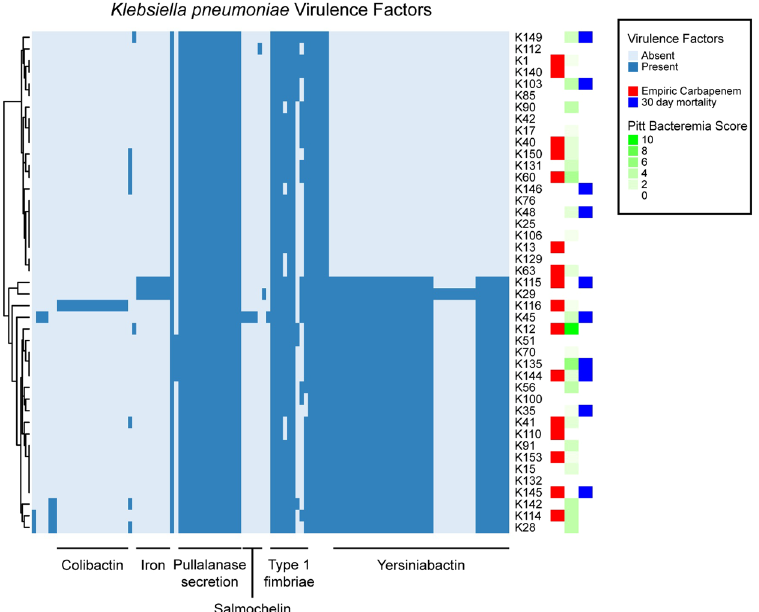
Figure 4. Heatmap of virulence factor calls from based on raw read mapping to VFDB for E. coli strains. Each row represents one E. coli strain, as indicated on the right of the heatmap. The strains are clustered based on their virulence factor profile, with the dendrogram displayed on the left. Each column represents one virulence factor, with selected general classes indicated below; a full list of virulence factors detected and their ordering in the heatmap can be found in Supplementary Table 1. Dark blue represents presence of a particular virulence factor in that strain; light blue indicates absence. Colored boxes on the right indicate empiric carbapenem, Pitt bacteremia score, and 30 day mortality associated with that